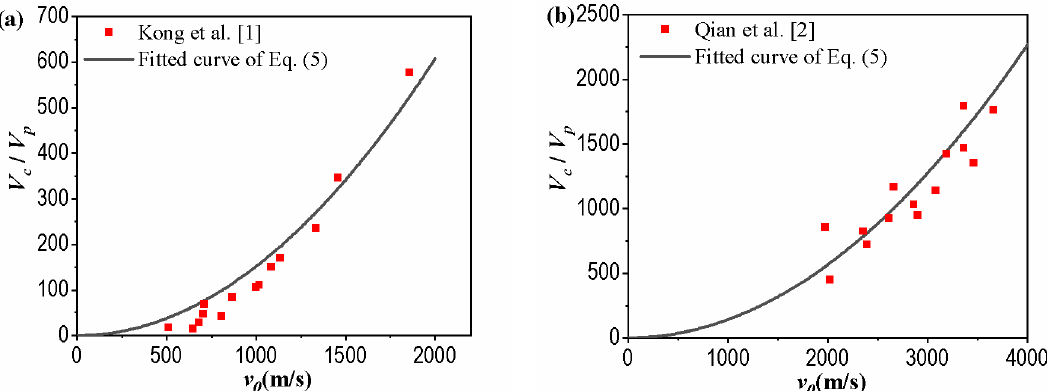
Appl. Sci. 2020 , 9 , x FOR PEER REVIEW Figure 14. Experimental crater volumes and fitted curve of Equation (5) ( a . R 2 = 0.986, b . R 2 = 0.825).